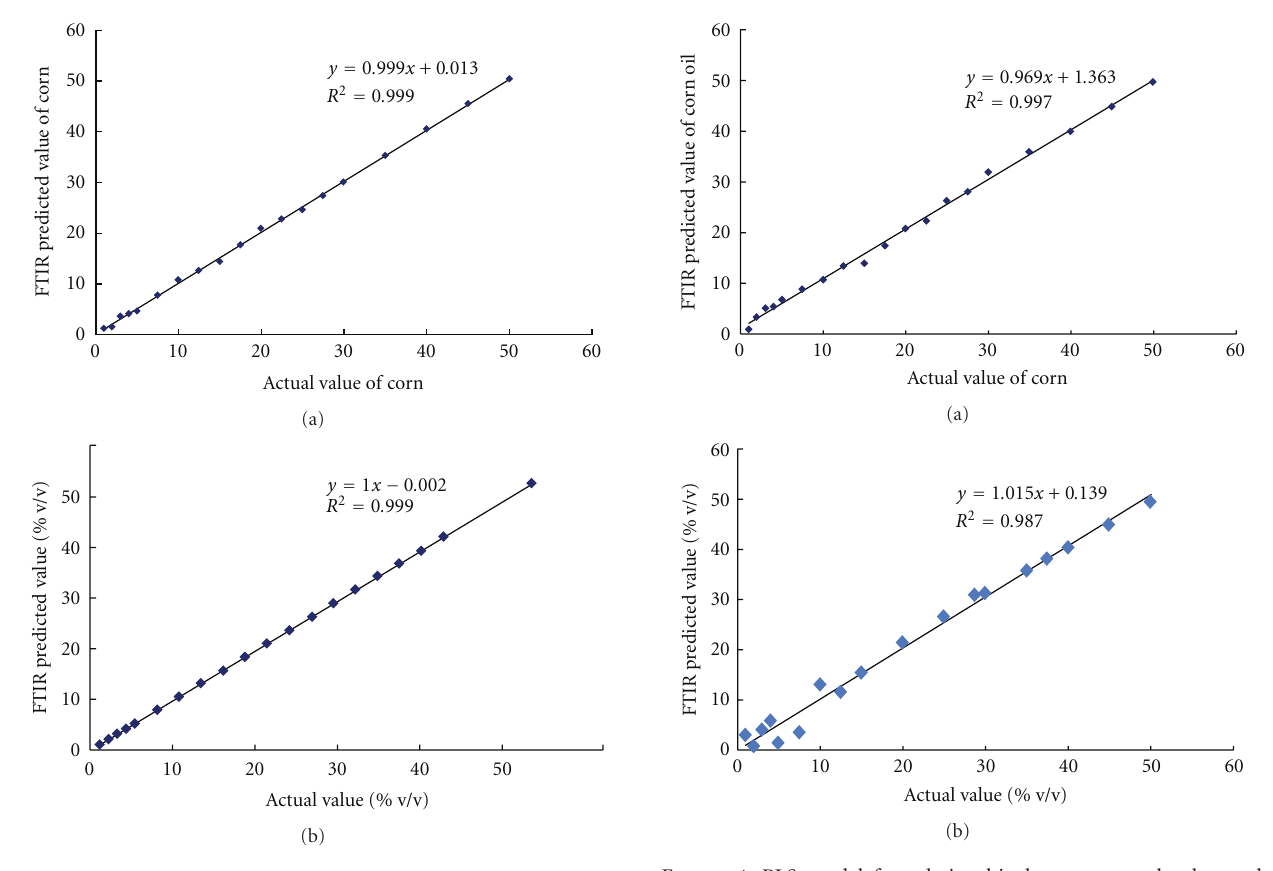
Figure 3: PLS model for the relationship between actual value and FTIR predicted value of corn oil in EVOO using FTIR normal spectra at 790–698, 1076–860, and 3027–3000 cm − 1 ; (a) calibration; (b) validation.